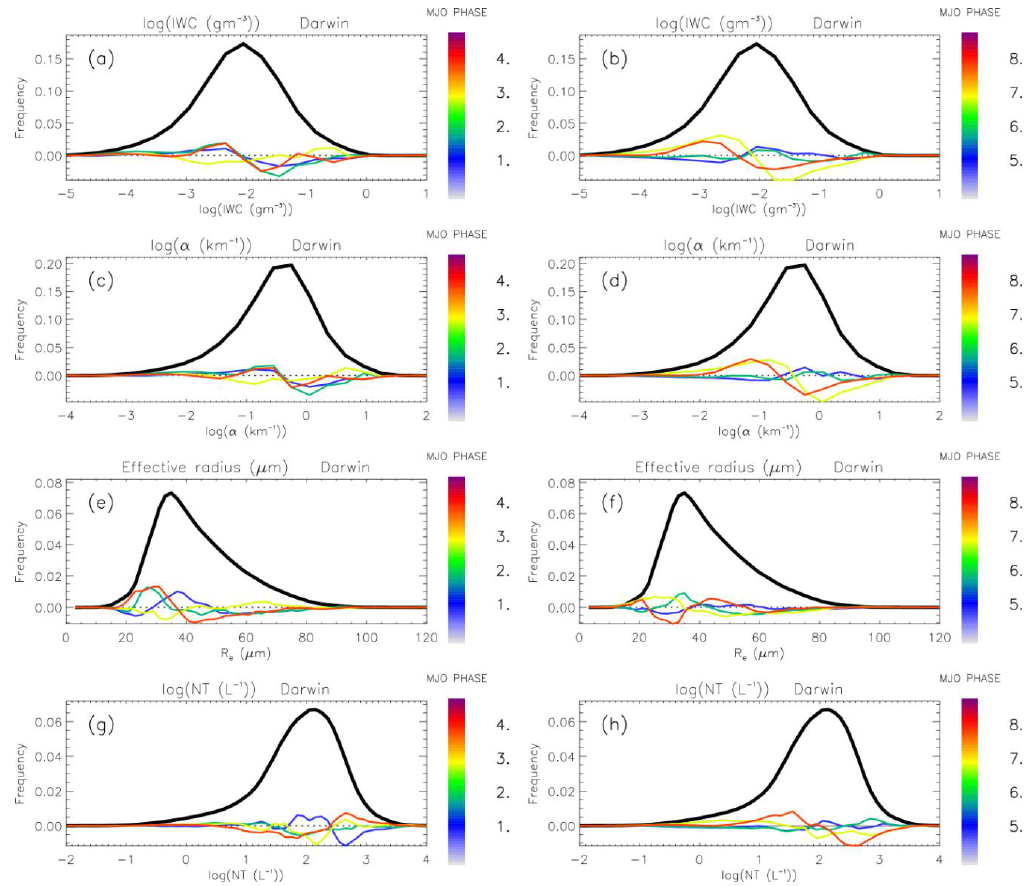
Fig. 19. PDF of cloud top height ( a for MJO phases 1 to 4, b for MJO phases 5 to 8) and geometrical cloud thickness ( c for MJO phases 1 to 4, d for MJO phases 5 to 8) with all regimes included (thick black line) and PDF difference for each MJO phase.